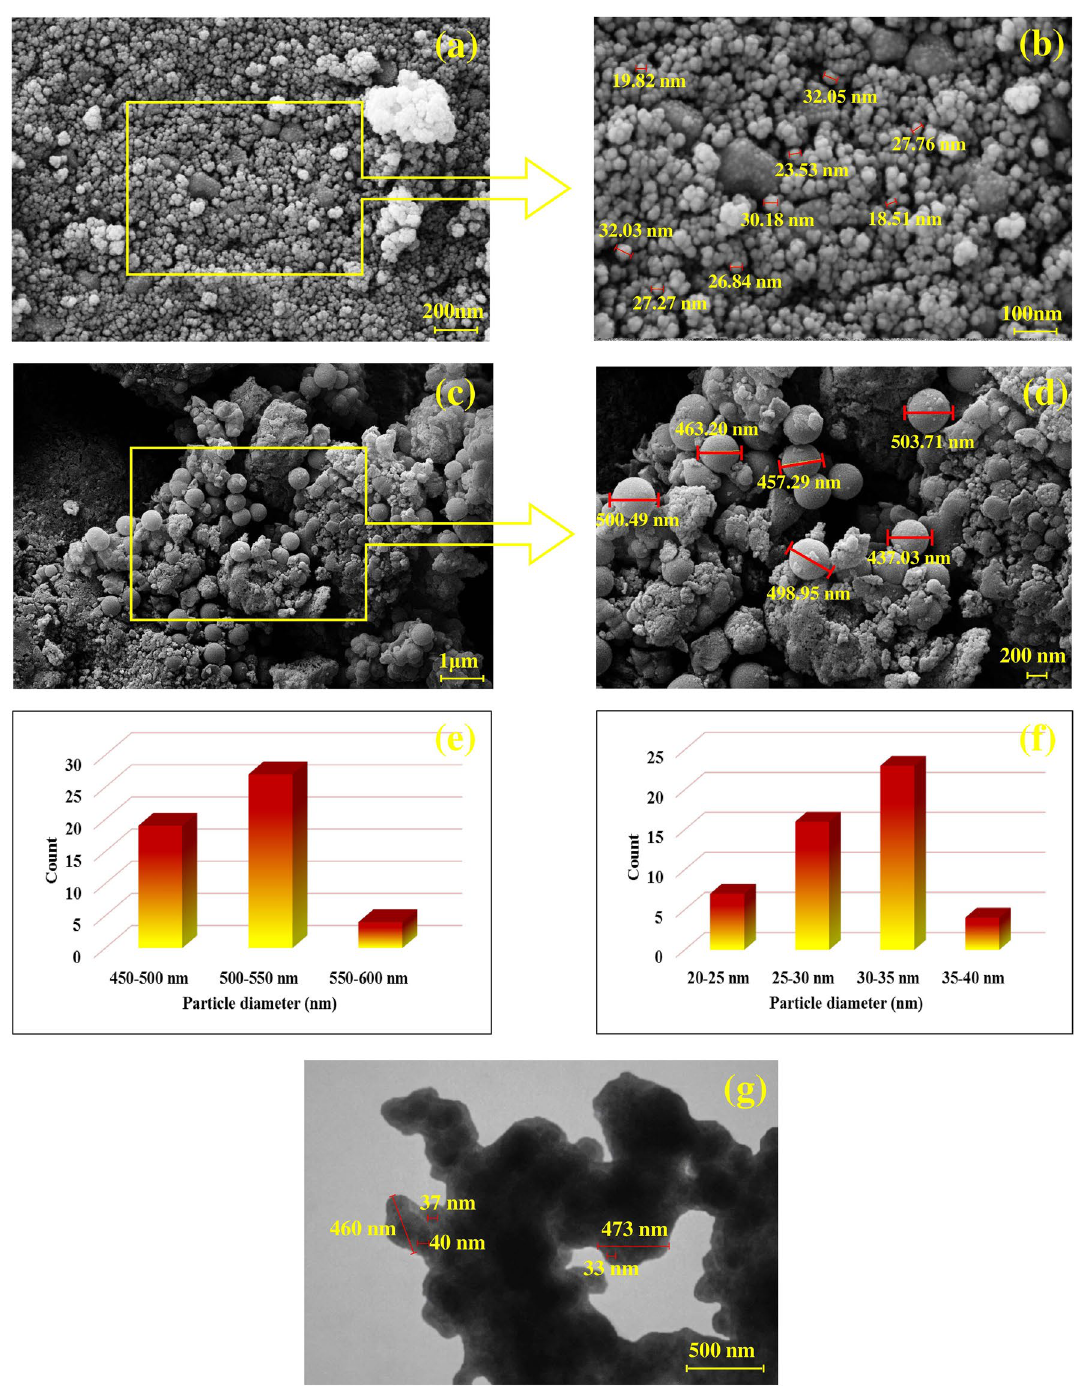
Figure 4. ( a , b ) FE-SEM images of ZnFe 2 O 4 MNPs, ( c , d ) magnetic hybrid based 1,2-phenylenediamine, ( e ) size distribution of magnetic hybrid based 1,2-phenylenediamine, ( f ) size distribution of ZnFe 2 O 4 MNPs ( g ) TEM images of magnetic hybrid based